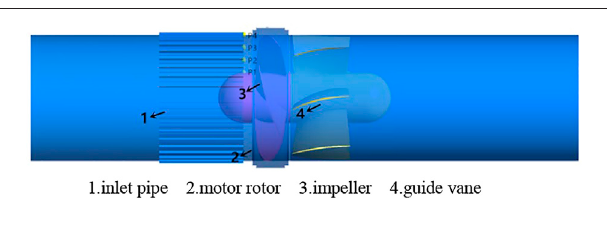
FIGURE 1 | 3D model of numerical calculation of full-tubular